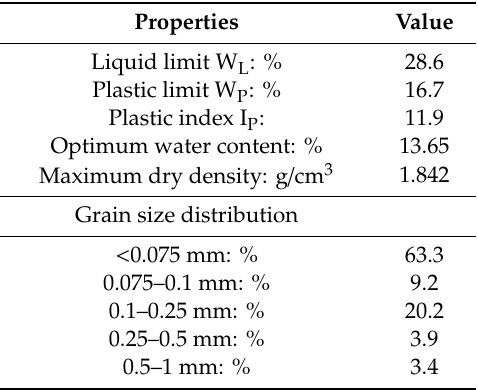
Table 1. Basic physical and chemical properties of the soil used in this study.